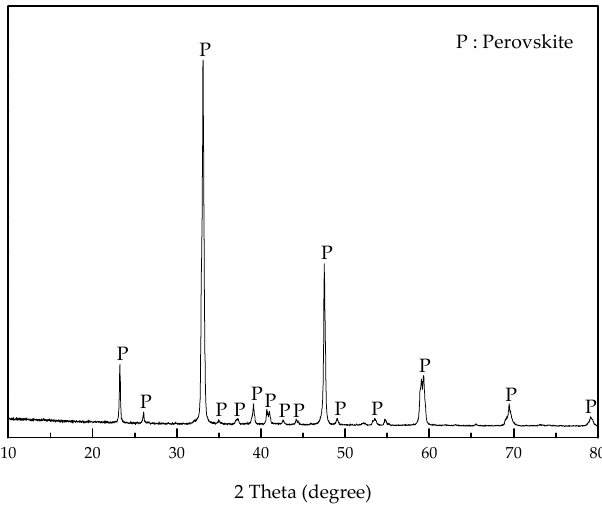
Figure 1. XRD spectrum of perovskite sample.